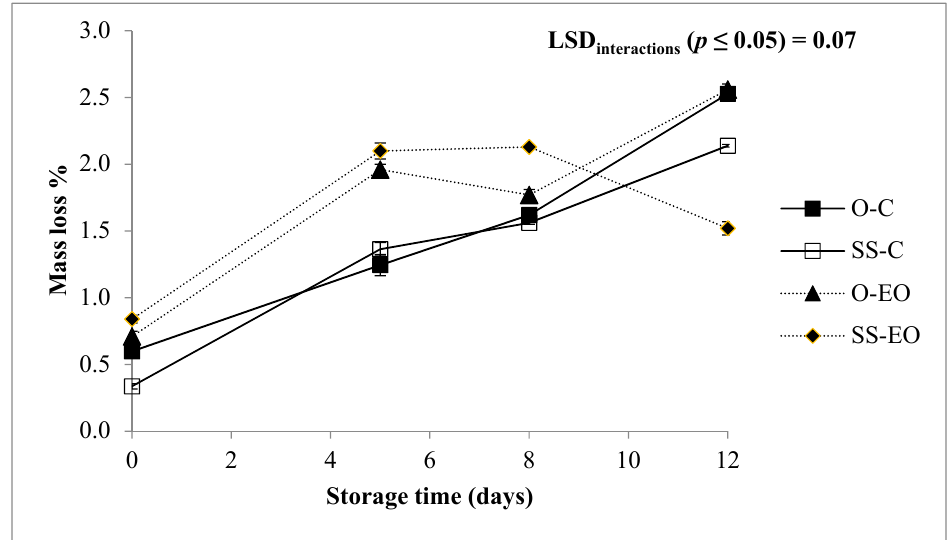
Figure 1. Mass loss (%) of RTC globe artichoke slices as affected by “genotype × post-harvest treatment × storage time” interaction. O: “Opera F1”; SS: “Spinoso sardo”; C: Control; EO: Samples packed with essential oil of Foeniculum vulgare. Data are reported as means ± standard deviation.